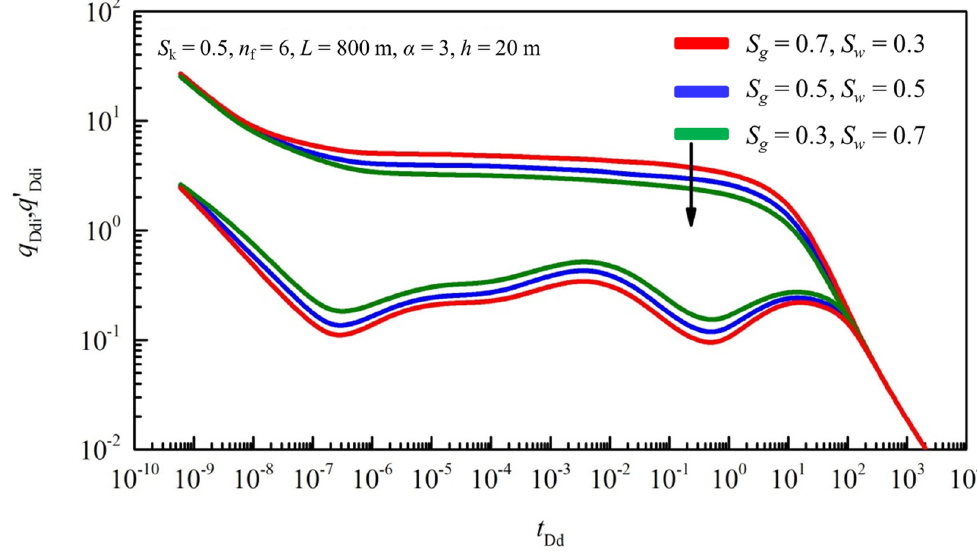
Figure 4. Effect of initial gas water saturations on dimensionless production integrals and derivative curve.